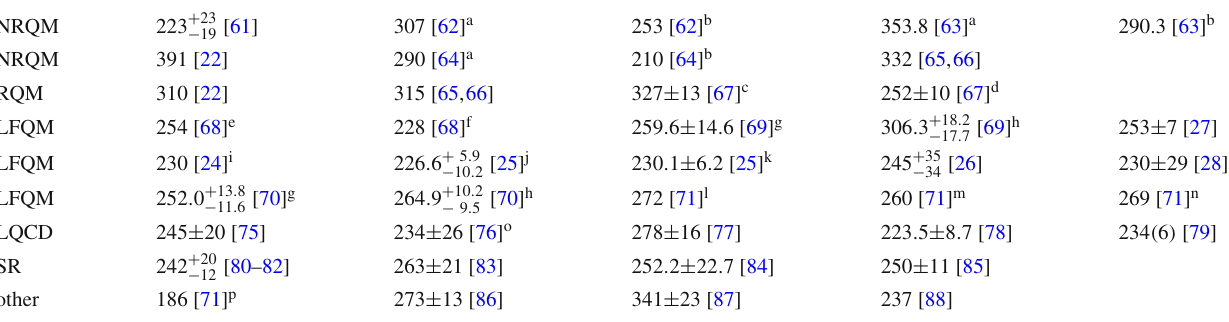
(in the unit of MeV), where the legends are the same as those in Table 1, NRQM is an d